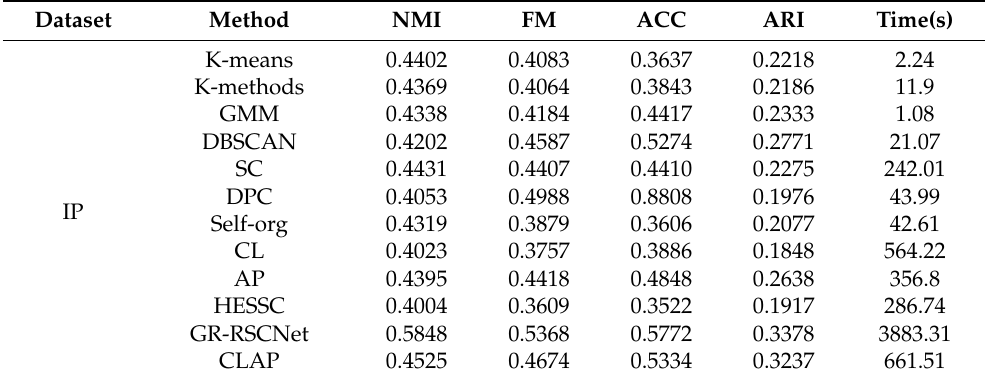
Figure 6. The unsupervised clustering maps of the Pavia University dataset. ( a ) K-means. ( b ) K- methods. ( c ) GMM. ( d ) DBSCAN. ( e ) SC. ( f ) DPC. ( g ) Self-org. ( h ) CL. ( i ) AP. ( j ) HESSC. ( k ) GR- RSCNet. ( l ) CLAP. Table 4. Comparison results of the NMI, F-measure, ACC, ARI, and running time of the algorithms in three HSI